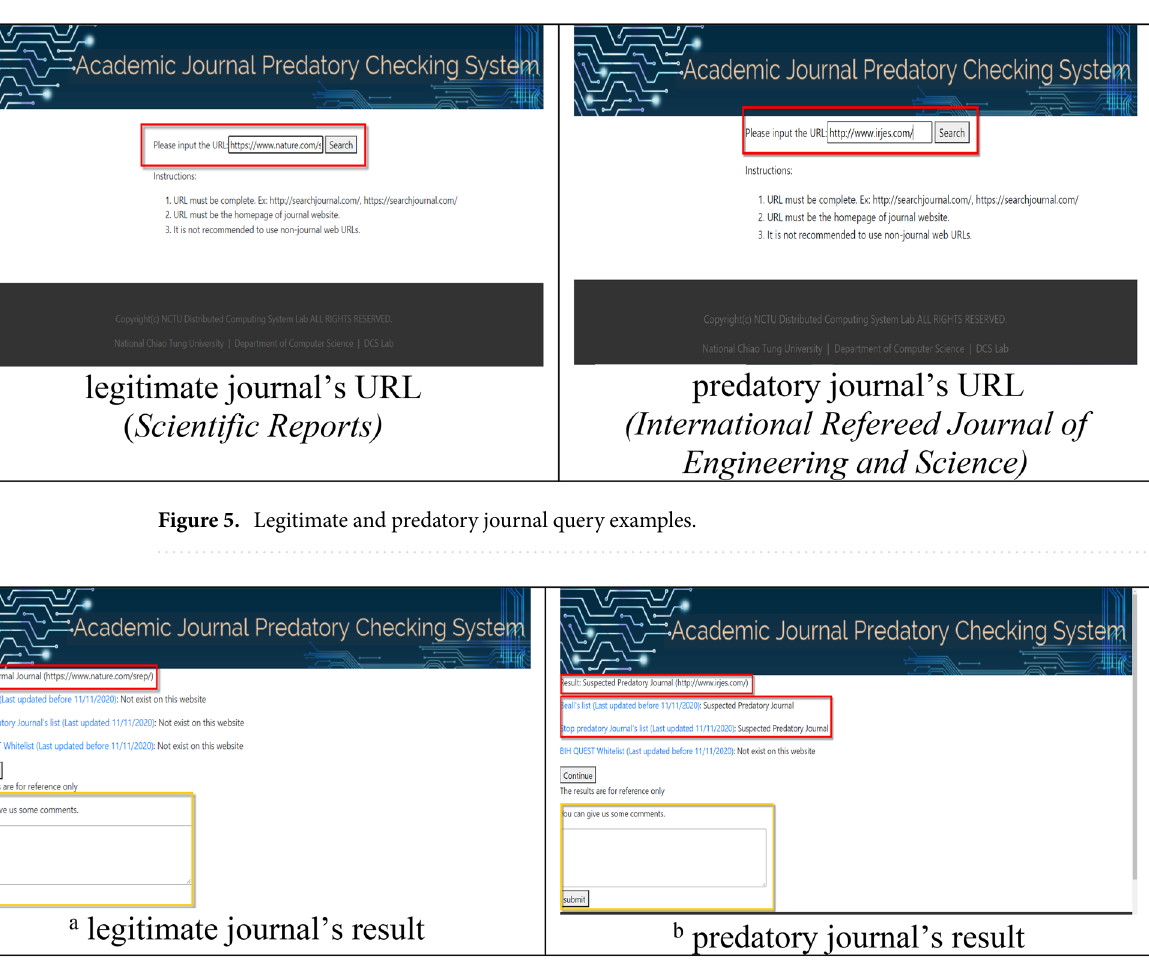
Figure 6. Legitimate and predatory journal query results returned by the AJPC